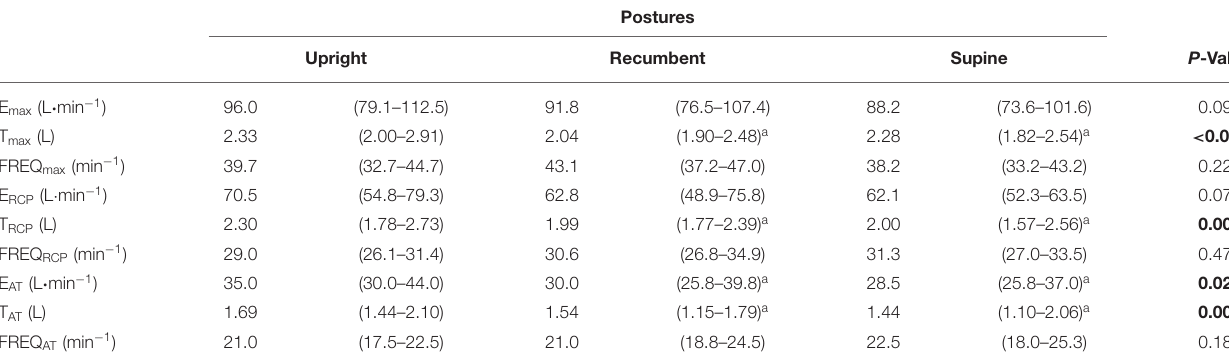
TABLE 2 | Ventilatory strategy in three different cycling postures.